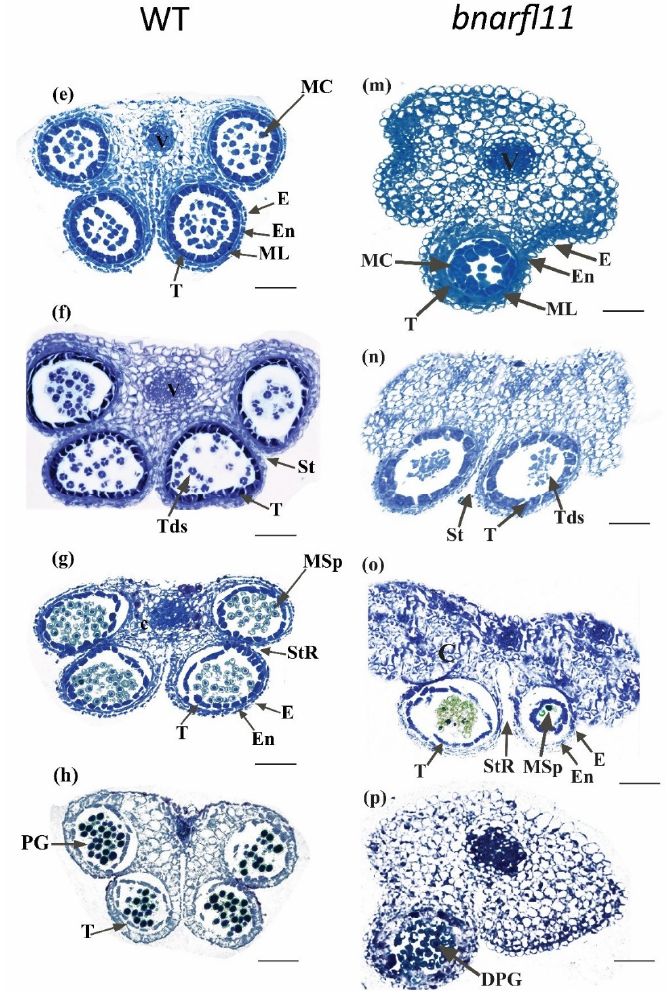
Figure 8. Cytological analysis of bnarfl11 ( i – p ) compared to the wild type ( a – h ). There is no significant difference at early stages ( a , b , i , j ), but at later stages ( c , d , k , l ), the loss of one or two locules per anther is evident. In ( l ), MMCs are intermittently formed with an intact tapetum in the locks compared to W.T. Ar , archesporial cell; E , epidermis; PSC , primary sporogenous cell; MMC , microspore mother cells; S.P. , sporogenous cell; En , endothecium; SPC , secondary parietal cell; ML , middle layer; T , tapetum; V, vascular region; PPC , primary parietal cell Bar = 10 μm. Cytological analysis of bnarfl11 compared to the wild type. ( e – h ) Stages of the wild type from 5–8 . ( m – p ) displays the stages of the sterile flower from 5–8 . ( m ) The Meiocyte stage with a highly dense callose wall around them and vacuolation in the tapetum was more confirmed than W.T. ( e , n ) At the tetrad stage, clumps of dense tissue in CMS locules, while in W.T. ( f ) locules and MC are typical. ( o ) At the pre-dehiscent stage, the locule increases in size, microspores form a cell clump, and the tapetum starts degrading; however, in W.T. ( g ), they have four large locules and normal microspores. ( p ) Degenerated pollen grains in the CMS flowers. ( h ) Normal pollen grains. T , tapetum; MC , meiotic cell; E , epidermis; St , stomium; Msp , microspores; S.P. , sporogenous cell; Tds , tetrads; V , vascular region; P.G. , pollen grain; DGP , degenerated pollen grains Bar = 10 μm.